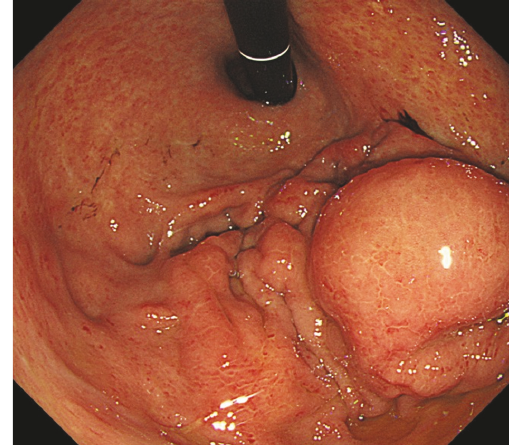
Figure 4: Another submucosal tumor was found in the gastric fundus without ulcer